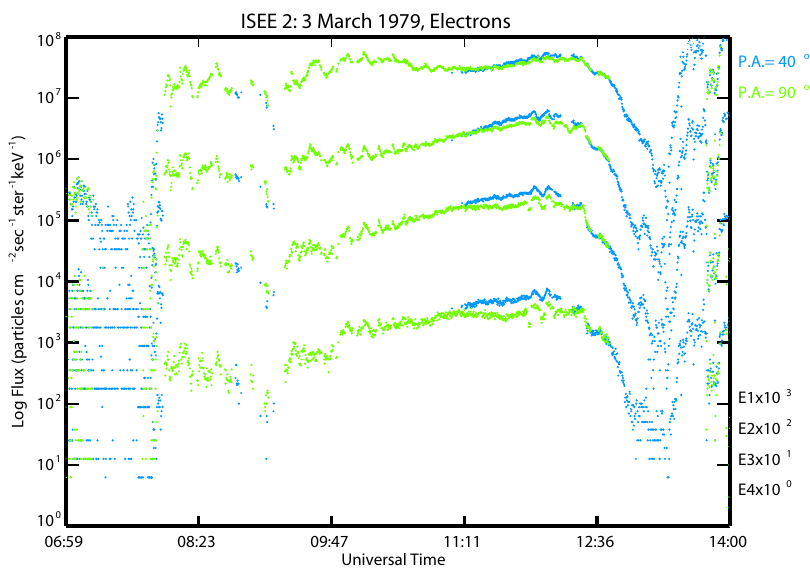
Fig. 8. ISEE-2 electron intensity as a function of time in the channels E1 (17.5–28keV), E2 (28–38keV), E3 (38–48keV), and E4 (48– 62keV) observed at 07:00–14:00 UT on 3 March 1979. The pitch angles displayed are 40 ◦ ± 5 ◦ and 90 ◦ ± 5 ◦ .